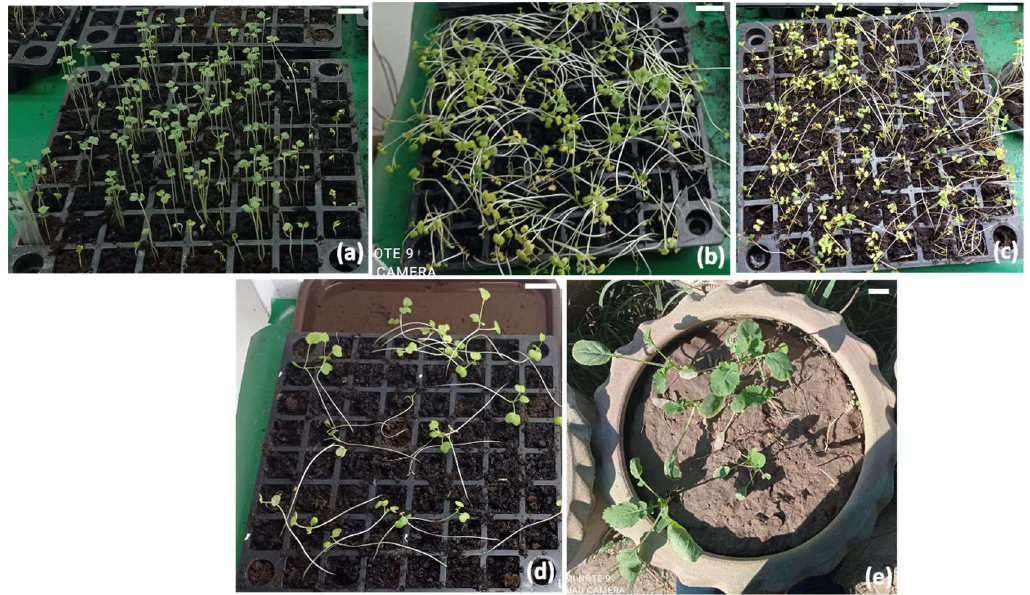
Figure 4. Transgenics selection with basta herbicide (Glufasinate-ammmonium), ( a ) germinated seeds after 14 days, ( b ) survived plants after 10 days of the first spray, ( c ) survived plants after10 days of the second spray, ( d ) plants survived the herbicide selection, and ( e ) selected transgenes in earthen pots (Bars = 1